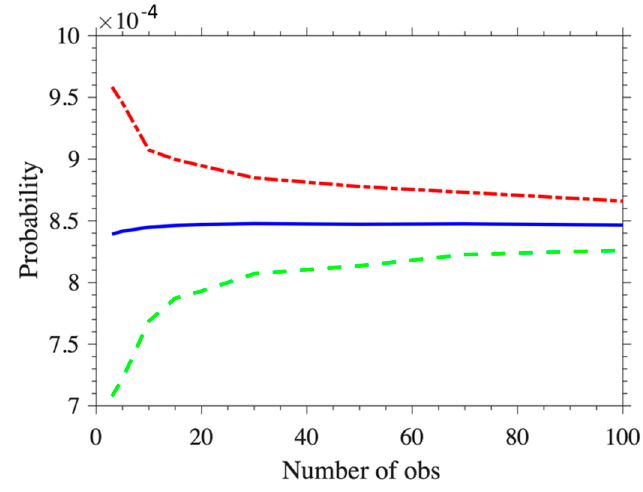
Figure 9. Mean, 5% and 95% confidence interval of the updated probability of failure at 5 years. Table 4. Errors of 5% and 95% fractiles of P f with different numbers of simulated inspection data. Errors Relative to Mean P f